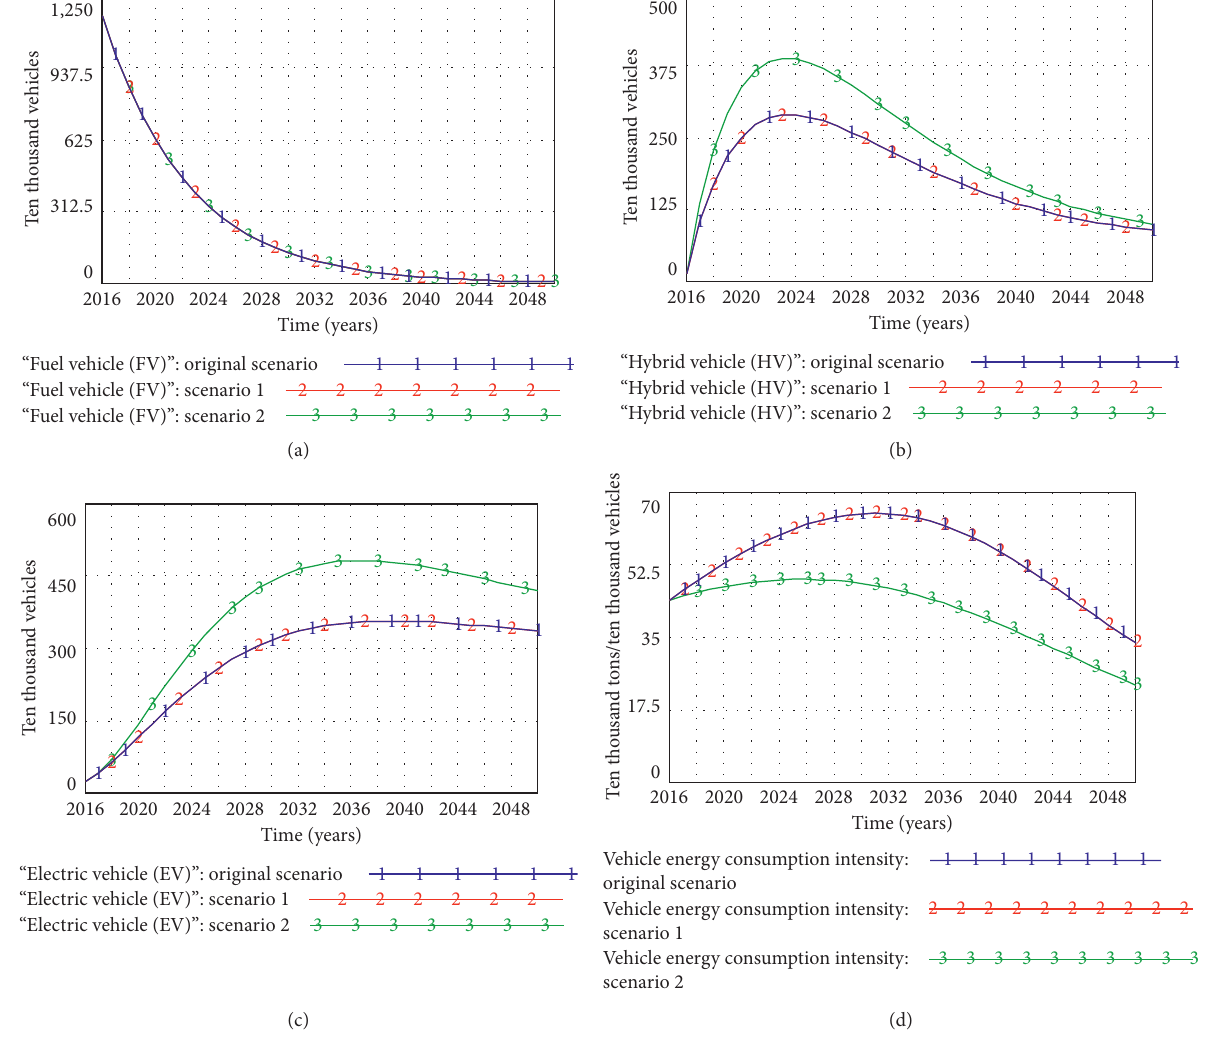
Figure 4: The changing trend of vehicles and vehicle energy consumption intensity under three scenarios. (a) FV. (b) HV. (c) EV. (d) Vehicle energy consumption Table 2: Time changes in the auto industry upgrade process under three scenarios.